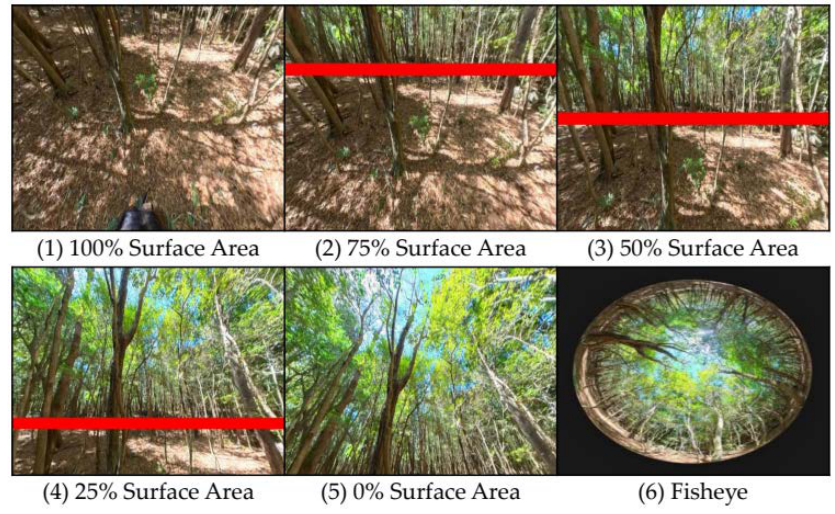
Figure 2. Reprocessed 360° images of the forest environment. A total of five forest light environment-related visual elements were extracted from each pre-processed image using Matlab, which are forest density, leaf area, lower